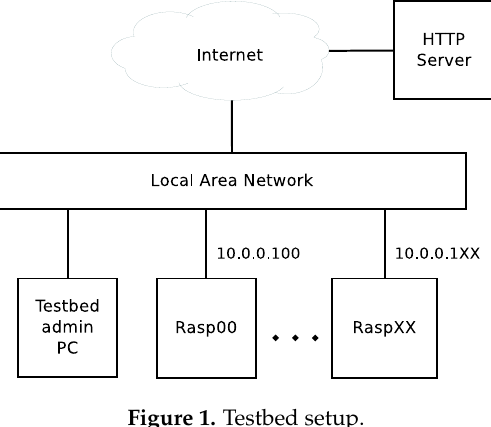
Figure 1. Testbed